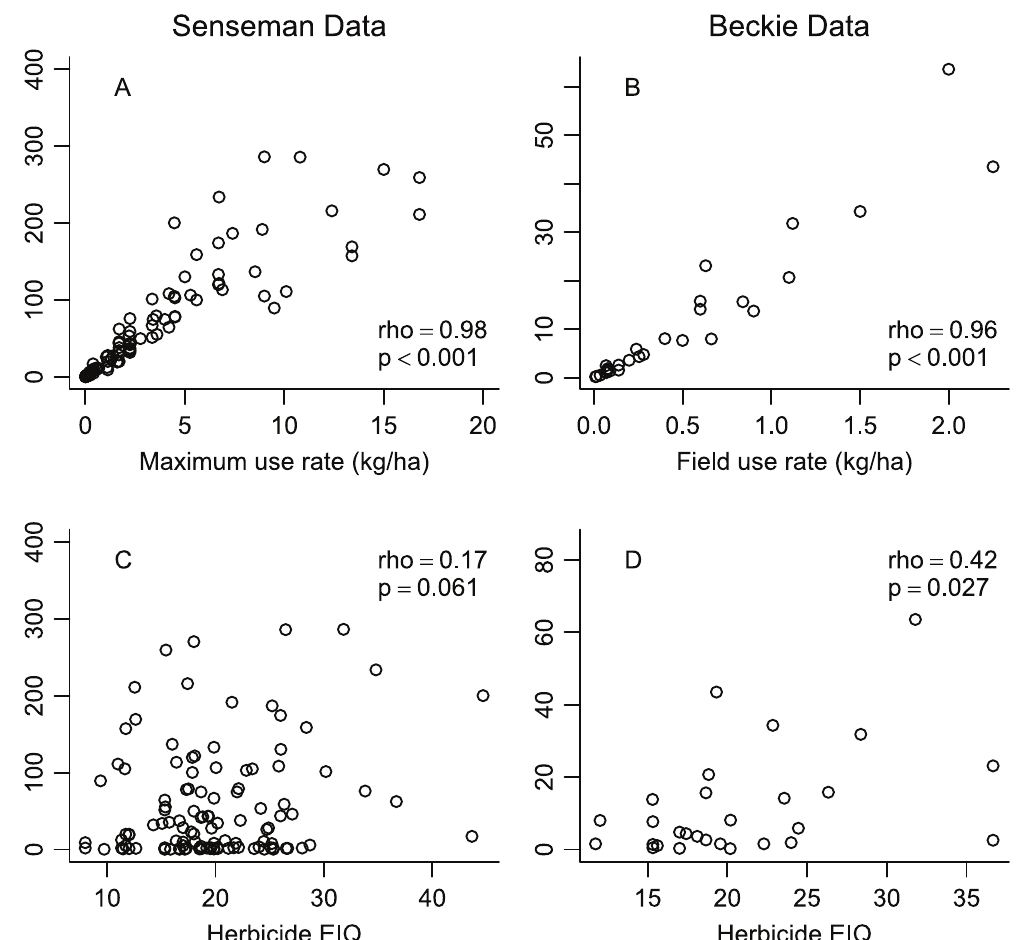
Fig 3. Relationship between Field EIQ and herbicide use rate (A,B) and the EIQ (C,D) for two herbicide data sets. (A) Relationship between maximum herbicide use rate and Field EIQ for Senseman data set; (B) relationship between herbicide field use rate and Field EIQ for Beckie data set; (C) relationship between herbicide EIQ and Field EIQ for the Senseman data set; (D) relationship between herbicide EIQ and Field EIQ for the Beckie data set. Spearman ’ s rank correlation rho and P-value are provided in each panel.